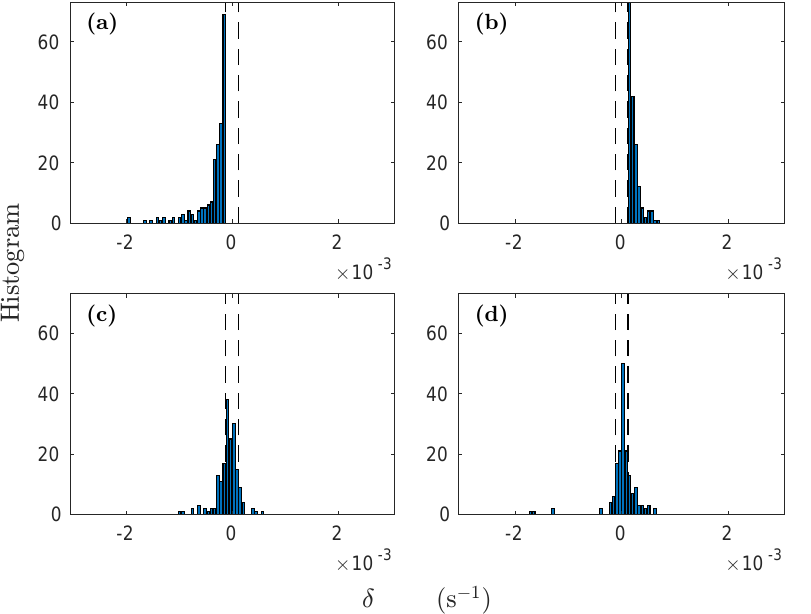
Figure 14. Sample result that compares information in SCAT-1 with that in SCAT-2 (50 min later). The top panels ( a , b ) show, respectively, statistical distributions of extreme wind convergence ( δ xc ) and divergence ( δ xd ), and bottom panels ( c , d ) show, for the same ocean areas, the change in SCAT-1 distributions after 50 min (SCAT-2